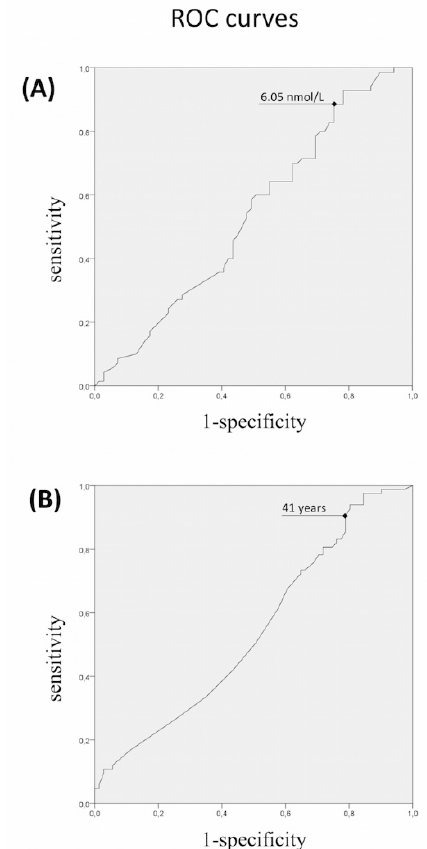
Figure 2. Receiver-operating characteristic (ROC) analysis of ( A ) total testosterone levels, and ( B ) age of onset, as indicators of the presence of rare variants in IHH genes. ROC curves were not significant “per se” but were used to find sensitive cutoffs able to identify patients with significantly higher risk of carrier status.